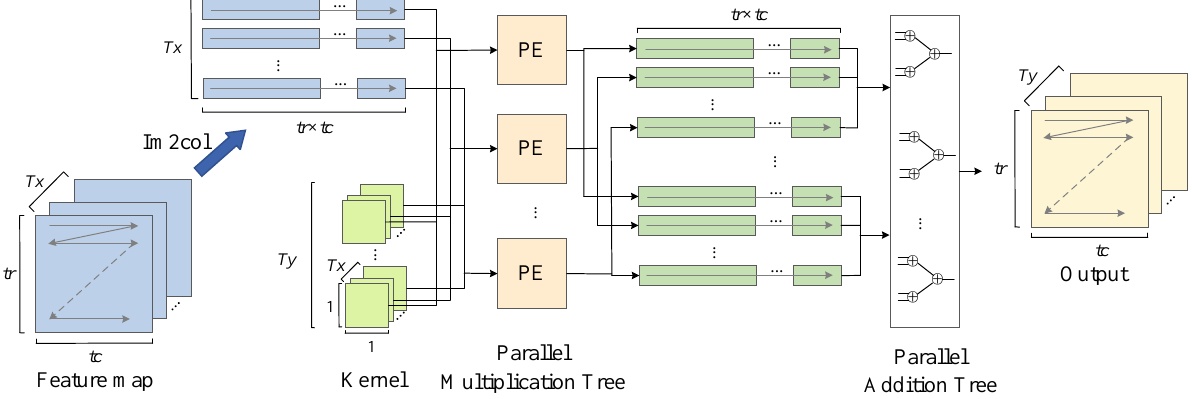
Figure 13. Architecture of the convolution module based on the Im2col+GEMM algorithm. Winograd